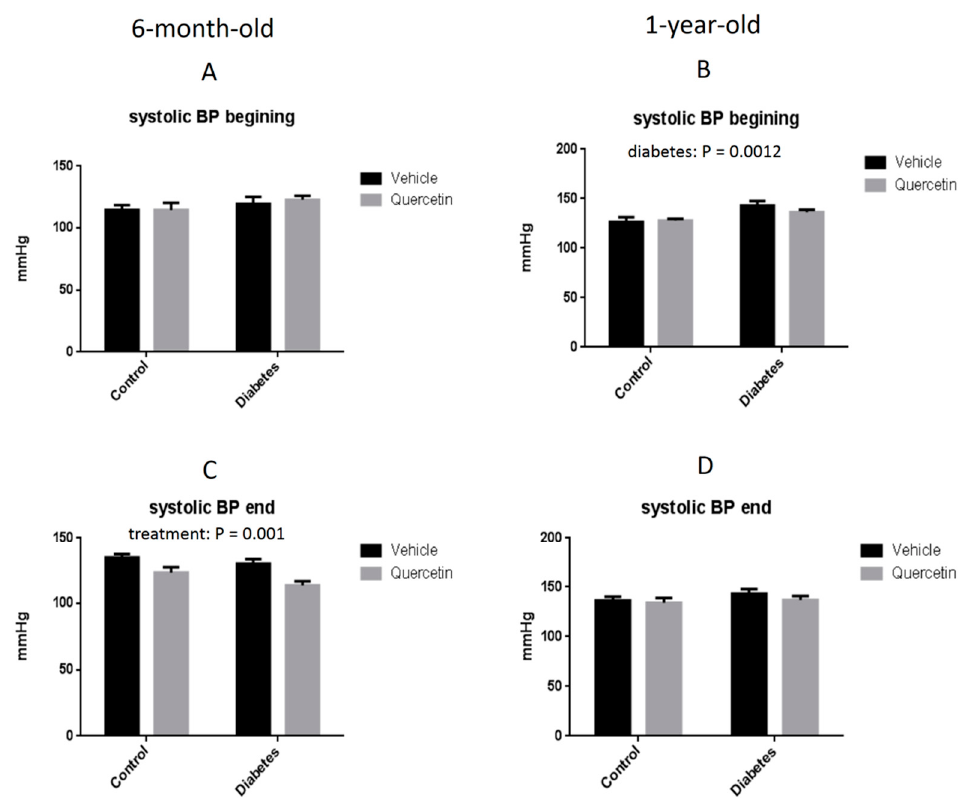
Figure 1. Systolic blood pressure (BP) measured by tail-cuff plethysmography in younger ( A , C ) and older ( B , D ) ZDF rats: BP beginning—measured before start of quercetin treatment ( A , B ); BP end—measured after the completion of quercetin treatment (end of week 6) ( C , D ). Results are expressed as means ± SEM. Significant differences were evaluated by two-way ANOVA for main factors diabetes and quercetin treatment.